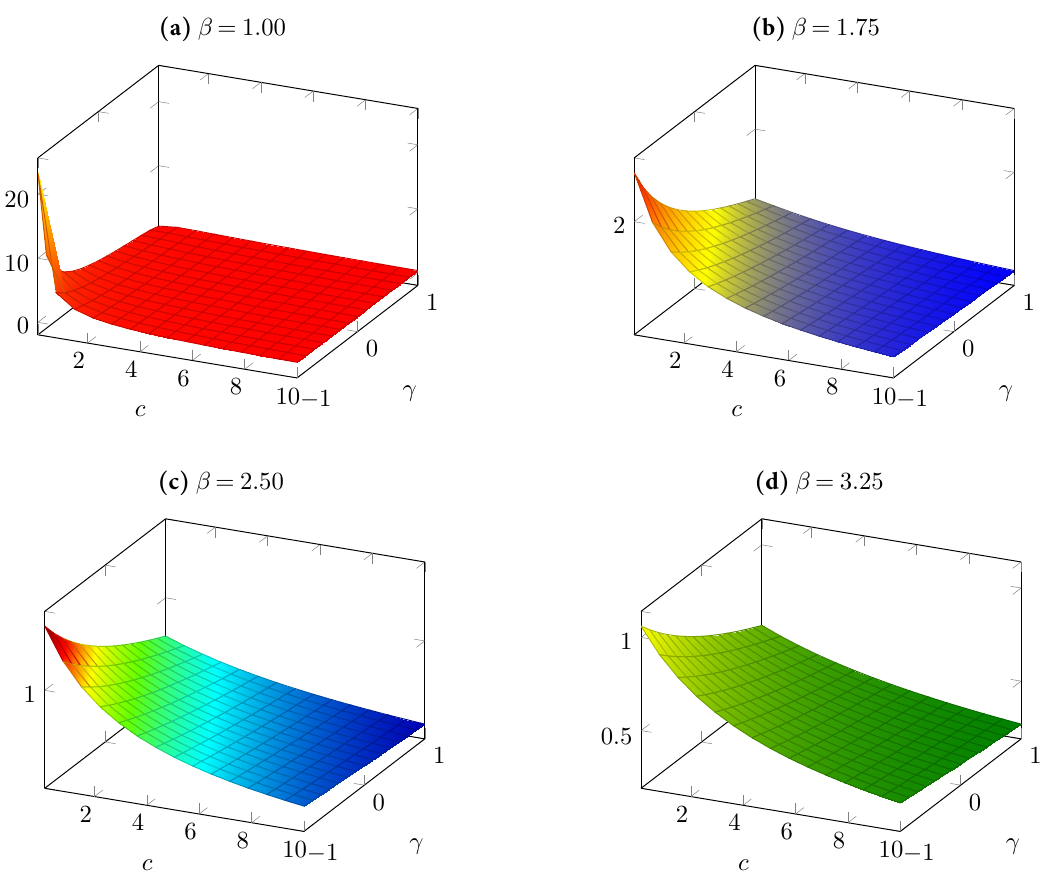
Figure 1. Plots of E [ π SF ( α )] for various values of β , γ , and c when E [ α 2 ] = 10. 243